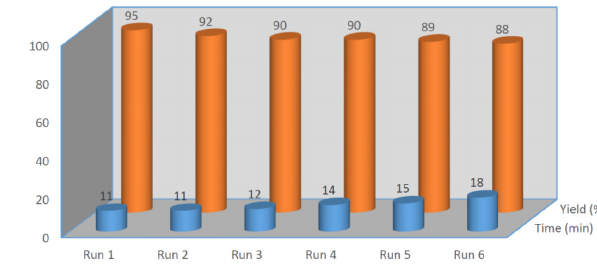
O MNPs in the N -acetylation of 2 4